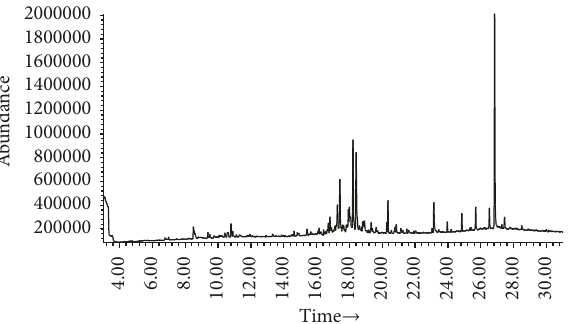
Time → Figure 1: GC/MS chromatogram of essential oil extracted from Cleistocalyx operculatus leaves . A total of 13 compounds were identified in CLO: 6-camphenol; isopinocarveol; p-cymen-8-ol; ( − )-myrtenol; I-verbenone; cis-carveol; ethaneperoxoic acid, 1-cyano-4,4-dimethyl- 1-phenylpentyl ethaneperoxate; (+)-carotol; caryophyllene oxide; ( − )-globulol; 2-(4a,8-dimethyl-2,3,4,4a,5,6-hexahydronaphthalen-2- yl)propan-1-; and longipinocarvone. Among them, many bioactive compounds identified in CLO exhibited antimicrobial and/or anti- inflammatory activities. This finding supports the idea of using Cleistocalyx operculatus essential oil as topical agent for treatment of burn wound, at least to prevent the infection and